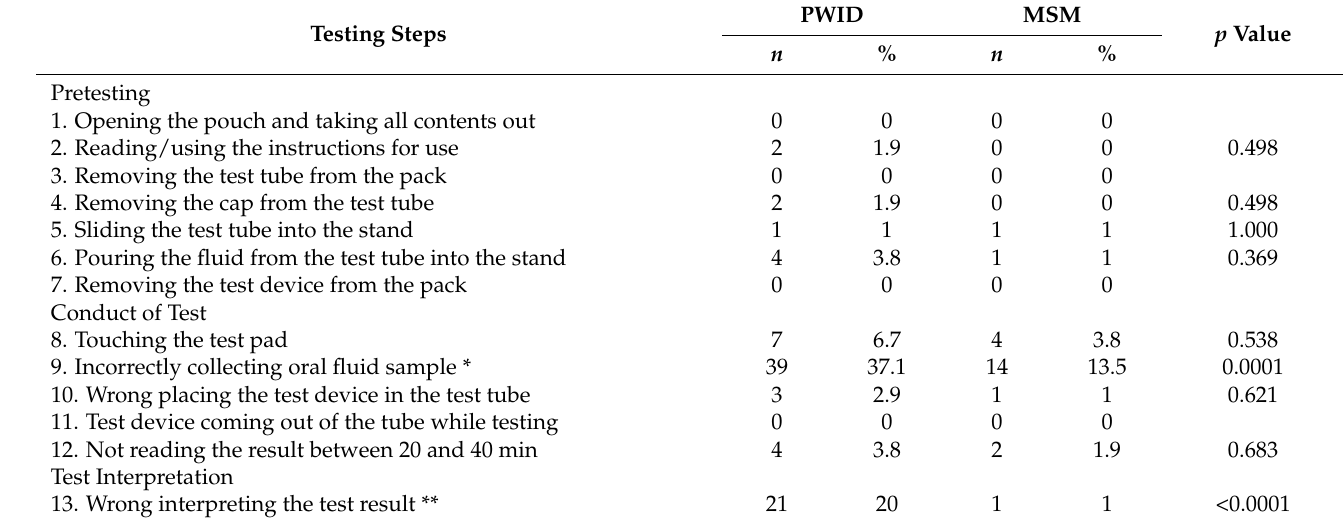
Table 2. Observer assessment of mistakes (using product-specific